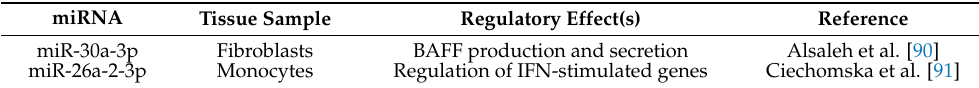
Table 5. Immune dysfunction and